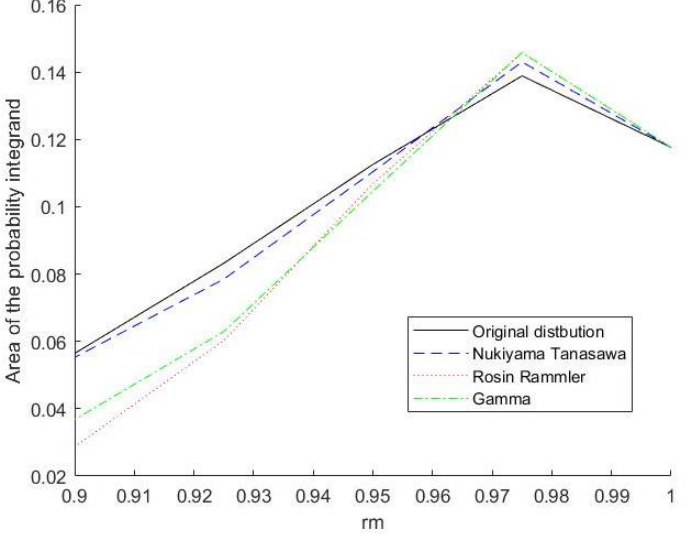
Figure 5. The area of the probability integrand as a function of the r m for the various distributions (Nukiyama–Tanasawa, Rosin—Rammler, and